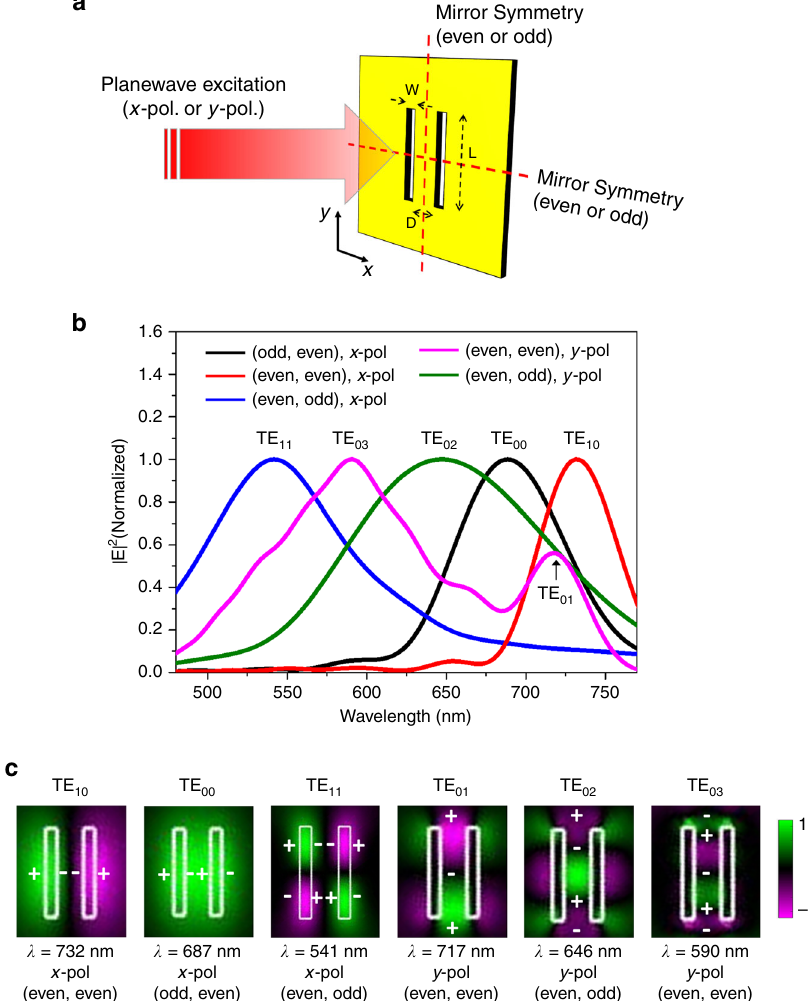
Fig. 4 Numerical mode analysis of the double nano-slits. a Schematic sample geometry along with far- fi eld excitation geometry. The polarization direction of the excitation source is selected to either x - or y -direction. Geometric parameters were taken from the experimentally fabricated double nano-slits ( L = 160 nm, W = 20 nm, and D = 50 nm). b Maximum |E | 2 spectra measured above the upper surface of the sample under mirror symmetry conditions of electric fi eld along the xz - and yz -plane at the center of the nano-slits. Plots were taken for three representative symmetry conditions with two different polarization directions. Here, the notation of “ (odd, even), x -pol ” , for example, indicates that the simulation had odd and even mirror symmetry of electric fi eld with respect to the yz - and xz -plane, respectively, and the excitation source was set to x -polarization. c Spatial electric fi eld ( x or y ) maps of various near- fi eld eigenmodes TE nm , obtained 20 nm above the gold surface, identi fi ed from Fig. 4b. The maps are displayed in descending order according to the resonance wavelength for each polarization. Plus and minus signs indicate the charge distributions of the antenna